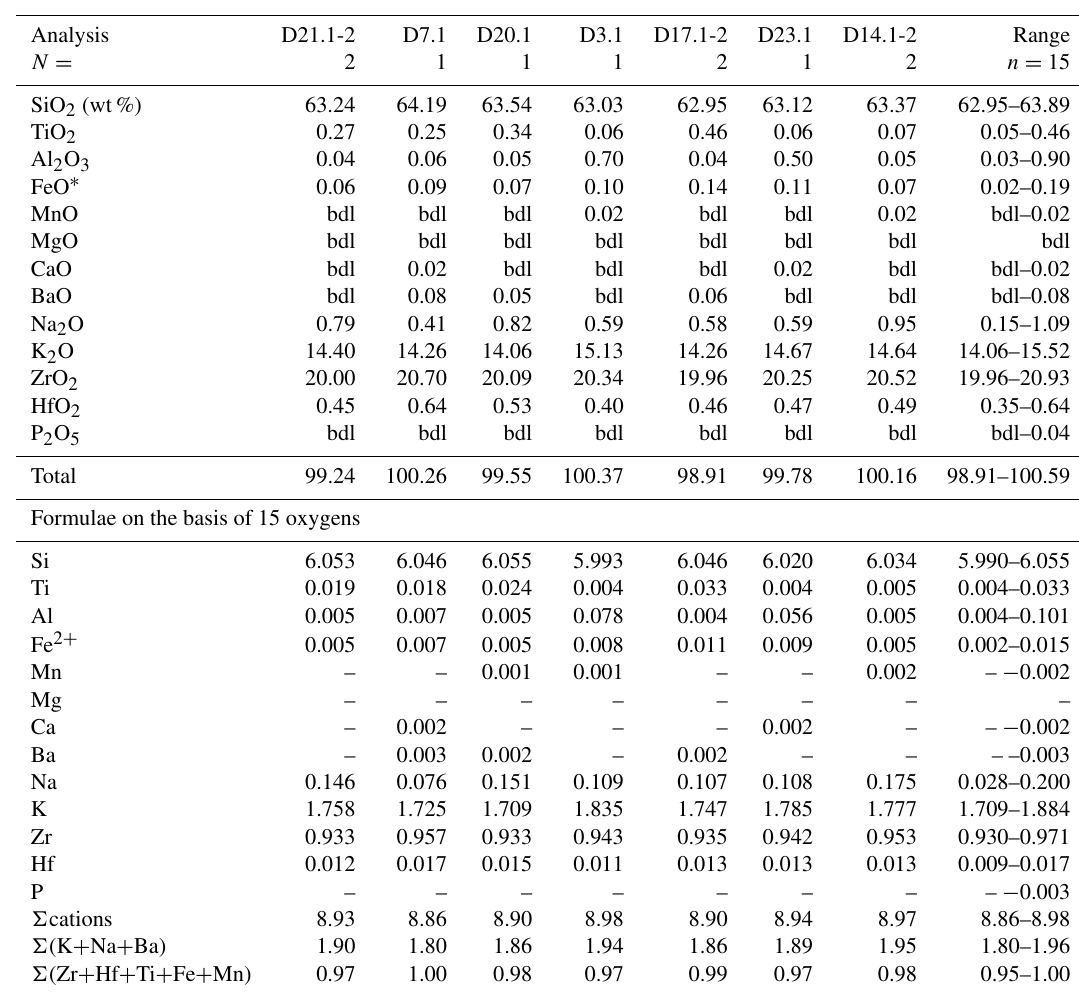
Table 12. Representative compositions of dalyite in Ailsa Craig granite DV24828.